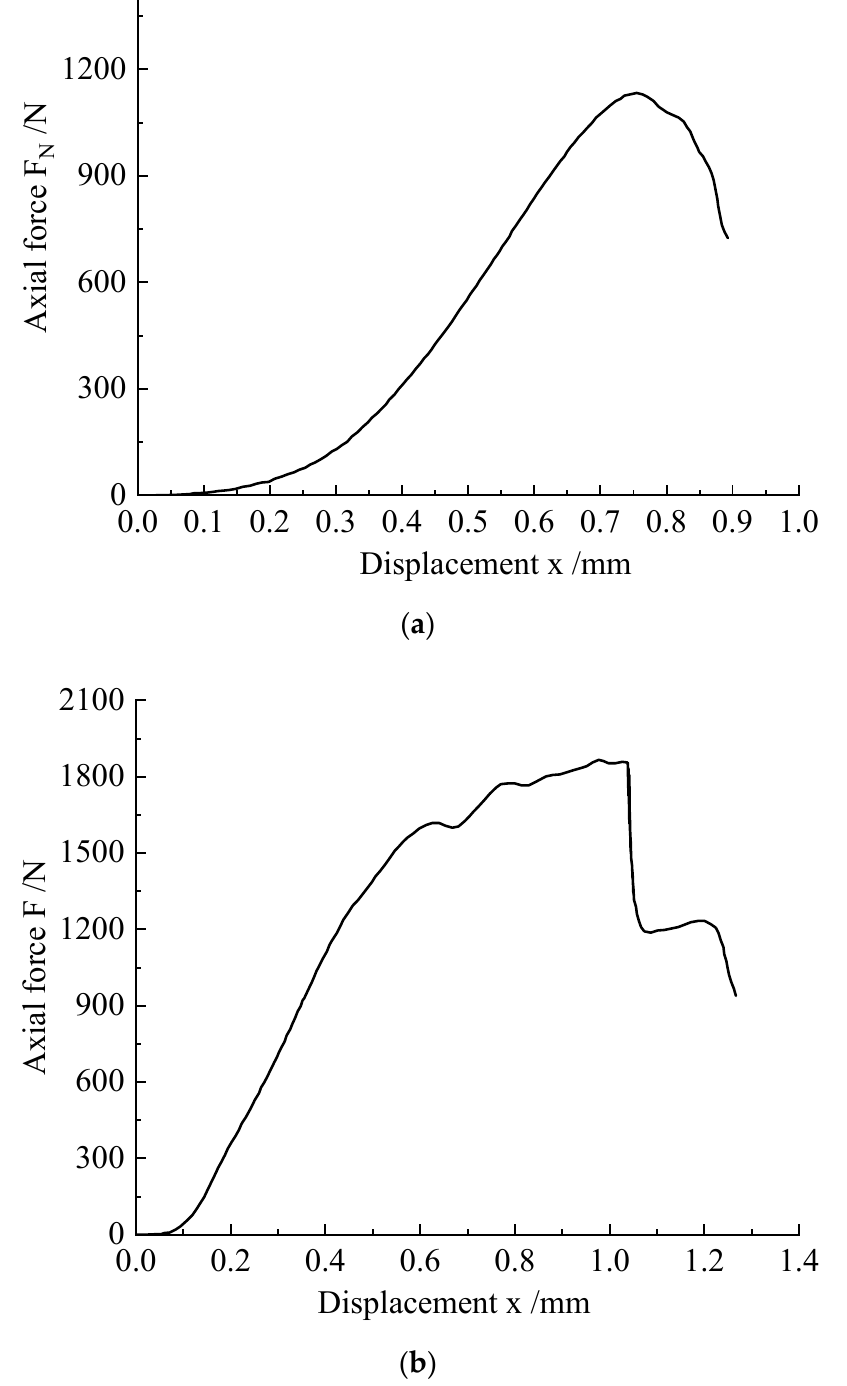
Figure 4. The axial force–displacement curves of M scheme combined with constant ‐ temperature samples with different cement concentrations. ( a ) Axial force–displacement curve of the constant ‐ temperature sample with an M ‐ 0.5 mol/L cementation solution. ( b ) Axial force–displacement curve of the constant ‐ temperature sample with an M ‐ 1.25 mol/L cementation solution.